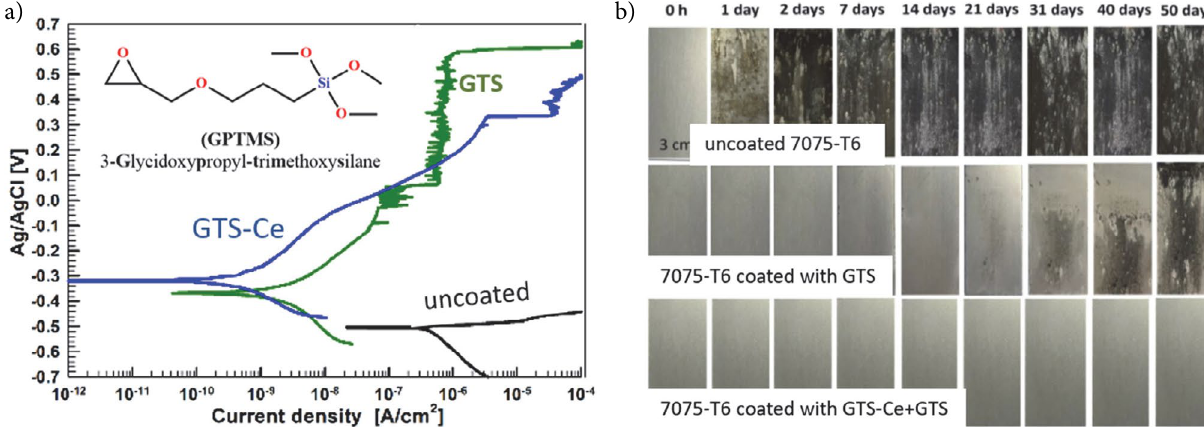
Figure 14. (a) Potentiodynamic polarization curves recorded in 0.1 M NaCl, after 1 h stabilization for bare AA7075-T6 aluminium alloy and coated with GTS and GTS-Ce coatings. d E /d t =1 mV/s. ( Reprinted from the publication by U. Tiringer, I. Milošev, A. Durán, Y. Castro, J. Sol-Gel Sci. Technol., 2018 , 85, 546 − 557 with permission from Springer Nature. 82 ) Skeletal formula of GPTMS is given in inset. (b) Images of uncoated aluminium alloy 7075-T6 and coated with GTS and GTS-Ce+GTS coatings during an immersion test in 0.1 M NaCl. Images were takes at different times of immer- sion up to 50 days. ( Reprinted from the publication by U. Tiringer, A. Durán, Y. Castro, I. Milošev, J. Electrochem. Soc., 2018 , 165, C1 − C13 with permis- sion from The Electrochemical Society. 87